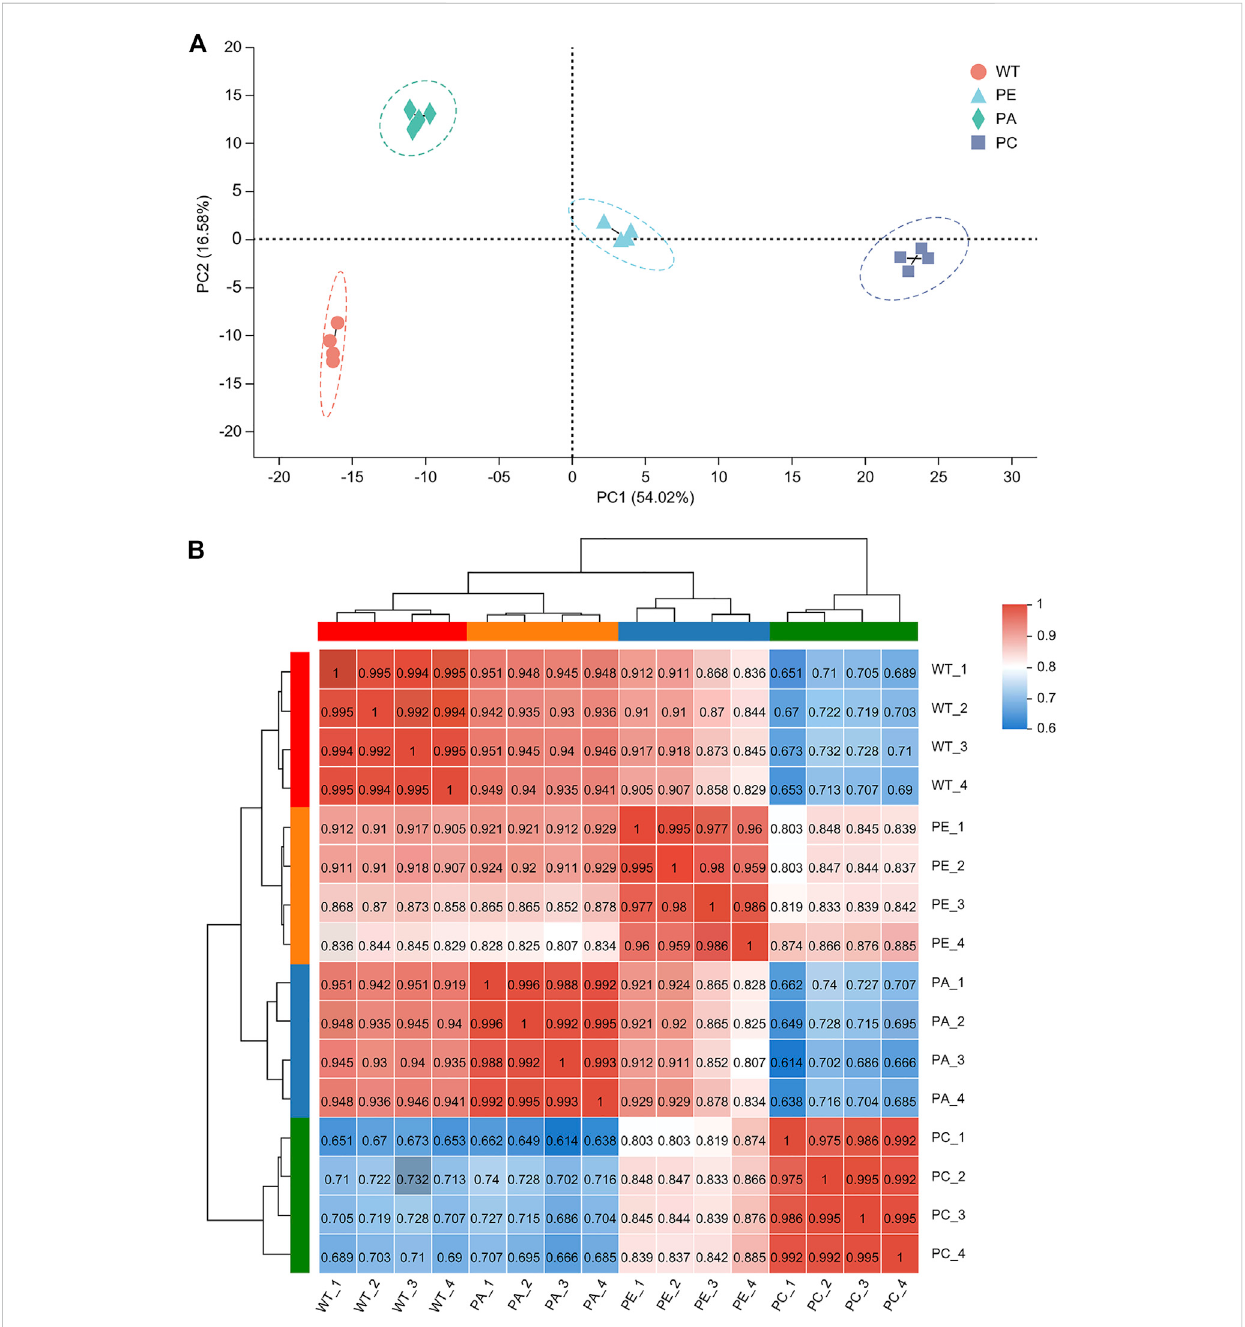
FIGURE 1 Analysis of sample correlation. (A) A principal component analysis (PCA) of the gene expression pro fi les of each sample. WT (orange circles): four wild-type samples; PE (blue triangles): four drought stress samples; PA (green diamonds): four samples sprayed with exogenous abscisic acid under drought stress; PC (purple squares): four samples sprayed with exogenous calcium under drought stress. (B) A heatmap of the Pearson ’ s correlation among 16 tomato samples. WT_1, WT_2, WT_3 and WT_4 represent WT; PE_1, PE_2, PE_3, and PE_4 represent PE; PA_1, PA_2, PA_3 and PA_ 4 indicate PA; and PC_1, PC_2, PC_3 and PC_4 indicate PC. Different colored squares indicate the degree of correlation between the two samples. The darker the red color, the higher the correlation between the two samples. The darker the blue color, the lower the correlation between the two